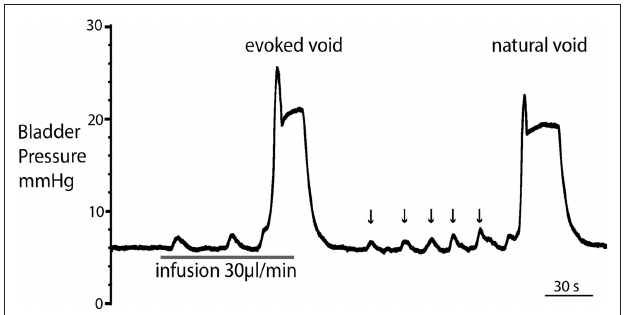
Figure 3 | Comparison of filling evoked and natural voiding responses. Natural voids occurred in most preparations as fluid from the kidneys filled the bladder. These were of qualitatively similar to filling evoked voids, with no significant differences in pressure trajectory or voiding threshold. Note also the presence of small, spontaneous non-micturition contractions (NMCs; arrowed).